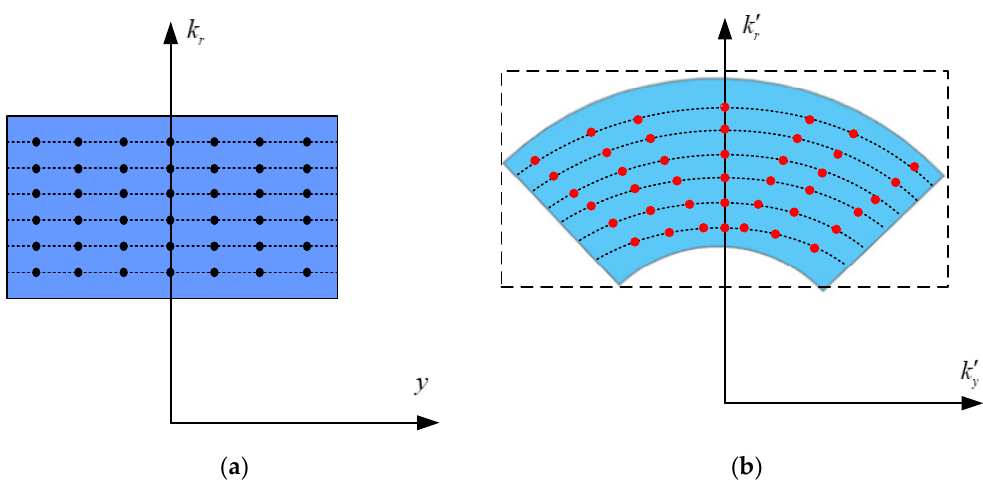
Figure 4. Raw data distribution change diagram of EPFA. ( a ) Sampled data before mapping; ( b ) sampled data after mapping.